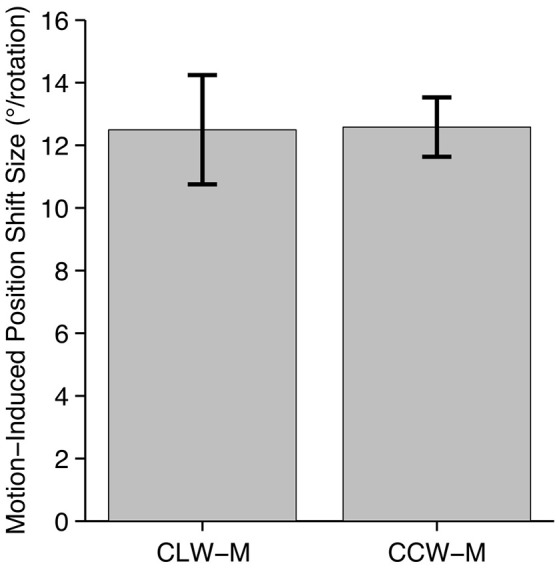
Psychophysical data. Average size of the motion-induced position shift across seven participants, based on data collected inside the scanner, prior to the fMRI experiment. Large, almost perfectly equivalent shifts were seen in both directions. Although the two conditions produced shifts in opposite directions, they are presented here as absolute values, to aid comparison.